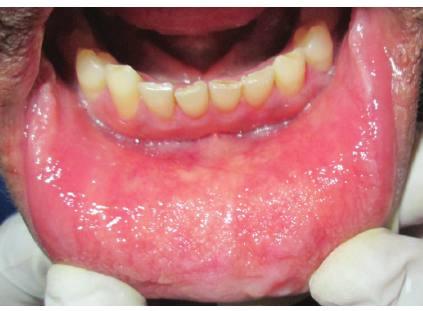
Figure 4: Diffuse yellowish waxy papular lesions were noted throughout the oral mucosa.